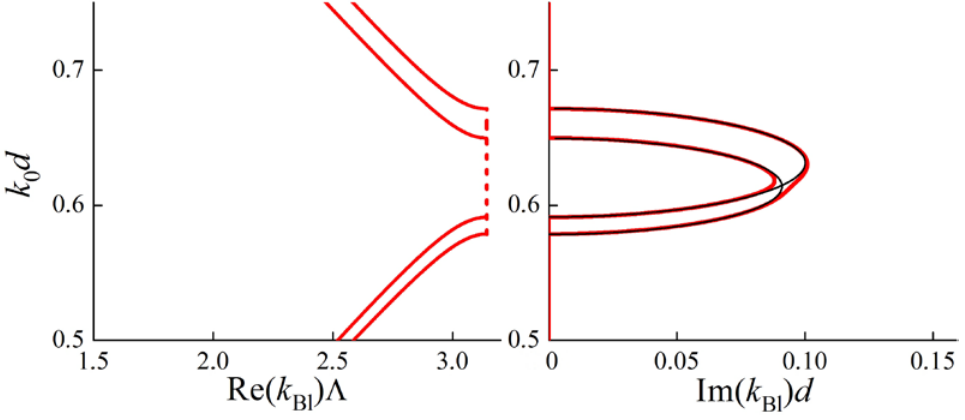
Figure 6. Bloch dispersion curves (red lines) for a PC with two layers of the same thickness d in a period. The optical axes of adjacent layers are misaligned by an angle of 0.3 rad. The parameters for the first layer of the period are: ordinary dielectric permittivity ord ε = ext ε = 5.0 5.4 , extraordinary one . The parameters for the second layer of the period 1 1 ord ε = ext ε = 7.5 7.8 are: ordinary dielectric permittivity , extraordinary one . A DBG does 2 2 not appear at the intersection of Brillouin BGs. The figure shows that the intersection of dispersion curves for different dispersion branches is not the only condition for a DBG to appear. Black lines corresponding to the case of collinear optical axes (the same as in Figure 4) are shown for reference. In the left figure for ( ) Re k Λ solid lines correspond to Bl pass bands, dashed lines correspond to band